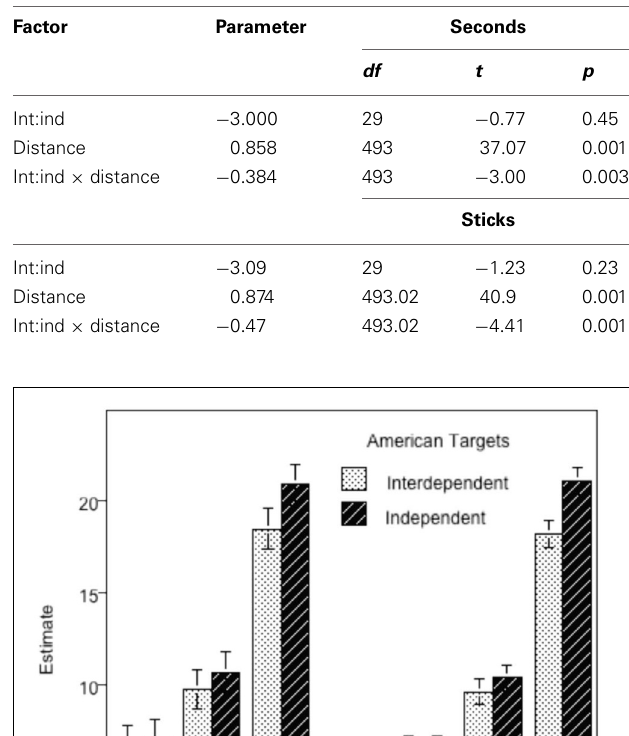
regression parameters to estimate means for interdependents and independents. The estimates for interdependents were